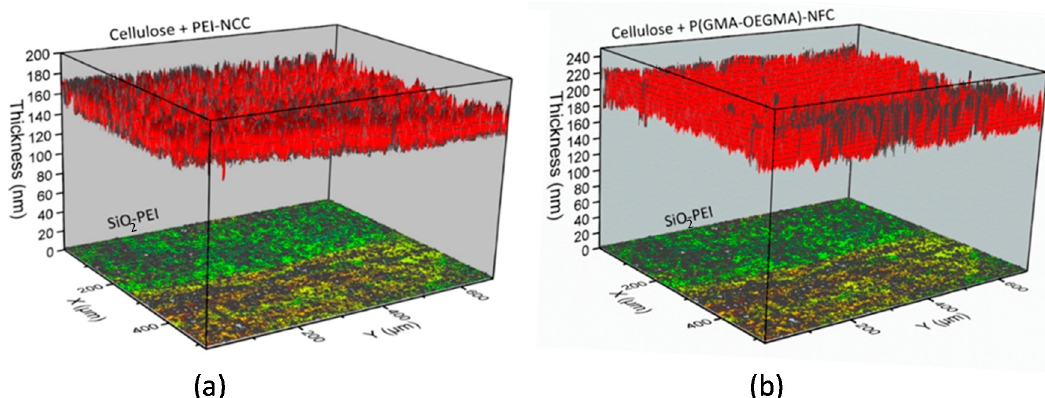
Figure 4. Representative examples of 3D-plots of layer-by-layer ellipsometric mapping of nanocellulose films on the polymer-coated Si-wafers constituted of the layers: ( a ) native SiO 2 (1 nm), poly(ethylene imine) (PEI) (1 nm), cellulose film (150 nm), PEI (1 nm), and NCC (20 nm); ( b ) native SiO 2 (1 nm), PEI (1 nm), CL (180 nm), PEI (1 nm), and NFC-copolymer of glycidyl methacrylate (GMA) and oligo(ethylene glycol) methacrylate (OEGMA) (P(GMA-OEGMA)) mixture (40 nm).